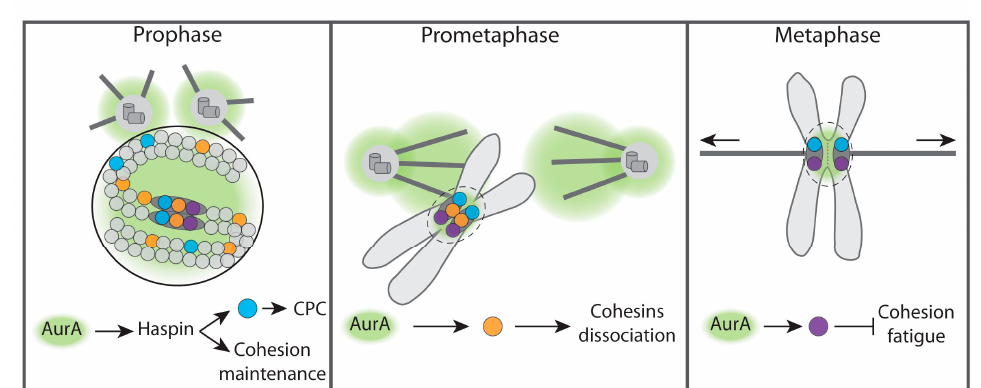
Figure 3. Histone phosphorylation events are controlled by Aurora A during mitosis. ( A ) Representation of an enlarged centromere showing nucleosomes (coloured circles). A nucleosome containing phosphorylated Threonine 3 of histone H3 (H3T3) is shown in blue, phosphorylated Threonine 118 of histone H3 (H3T118) is shown in orange. A nucleosome containing the centromere-specific phosphorylated Serine 7 of CENP-A (CENP-AS7) is displayed in purple. The light and dark grey circles represent histone H3 and CENP-A containing nucleosomes respectively. ( B ) Centromeric histone phosphorylations by Aurora A during mitosis and possible functions. During prophase and prometaphase, Aurora A (AurA, green) phosphorylates Haspin, a kinase required for cohesion maintenance and H3T3 phosphorylation at centromeres, necessary for CPC assembly. Aurora A also phosphorylates H3T118 on chromosome arms but mostly at centromeres. This phosphorylation may create a chromatin environment that promotes Cohesin dissociation. CENP-AS7 is phosphorylated at centromeres only. We speculate that the centrosomal pool of Aurora A is responsible for H3T118 phosphorylation because unaligned chromosomes in the vicinity of the centrosomes display more intense H3T118 signal (Middle panel). In metaphase, when chromosomes are aligned at the equator plate, phosphorylated H3T3 and CENP-AS7 are still present at the centromere, while phosphorylation of H3-T118 is lost. When sister chromatids are under tension, phosphorylation of CENPA-S7A by a centromeric pool of Aurora A (surrounded by the dashed line) prevents cohesion fatigue (Right panel).